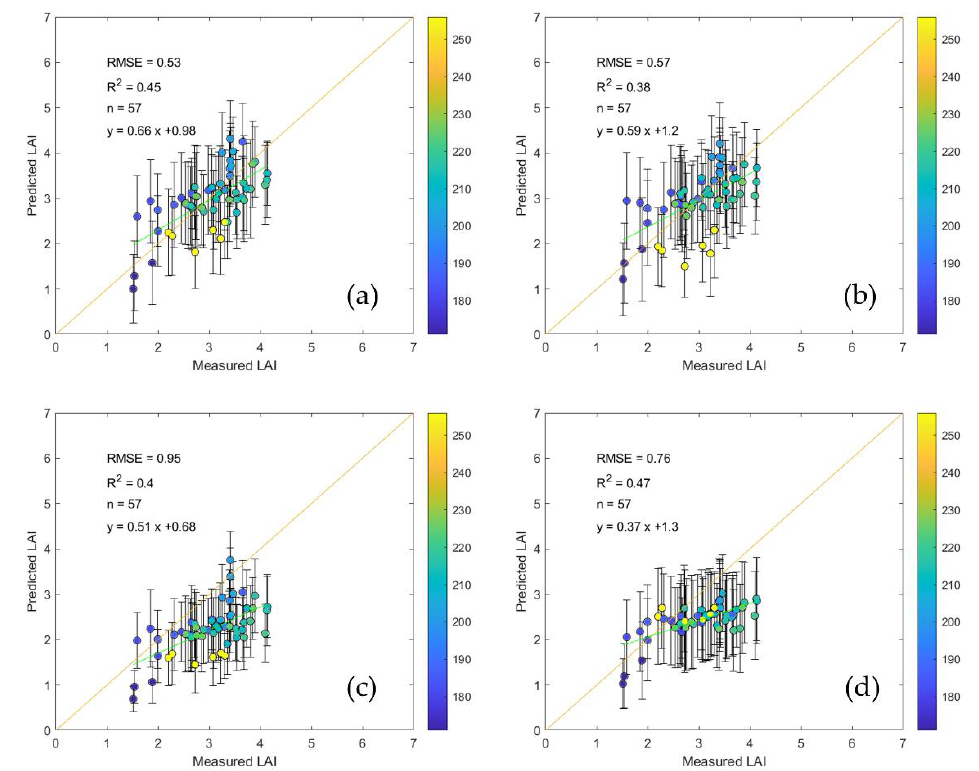
Figure 10. Comparison of LAI measured in situ and that estimated from VI-based LUT from Sentinel-2 data. The VIs used for inversion correspond to ( a ) CIgreen; ( b ) CIred-edge1; ( c ) NDVI; ( d ) EVI2. Error bar represents the standard deviation of LAI retrievals. Color bar represents DOY (i.e., day of year) of images.